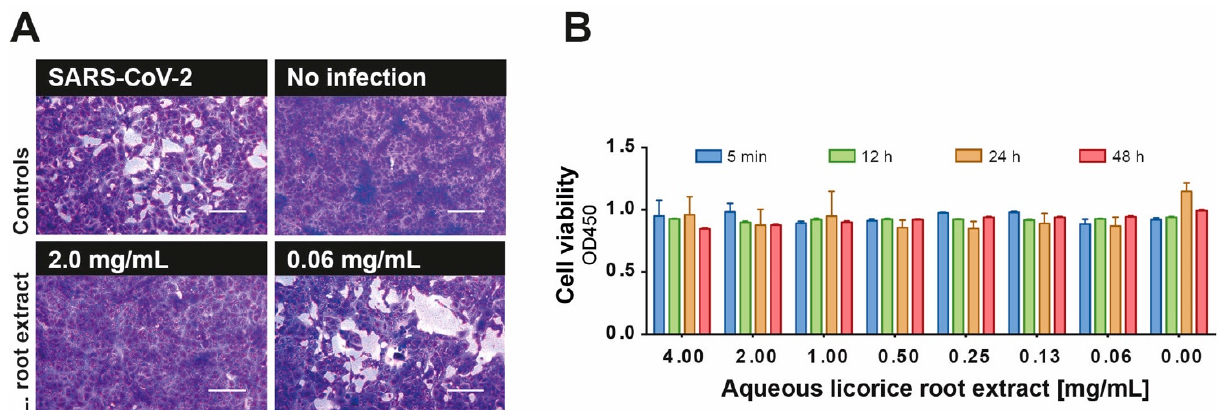
Figure 2. Potent inhibition of SARS-CoV-2 replication by the licorice root extract. ( A ) Decreasing aqueous licorice root extract concentrations (0.004–4 mg/mL) were pre-incubated with 100 TCID 50 /mL SARS-CoV-2 for 1 h at 37 °C and applied to a confluent layer of Vero E6 cells. After 48 h of incubation, cell cultures were stained with crystal violet and analyzed for plaque formation. Representative pictures of protected and infected cell cultures at the indicated concentrations are shown. Bars represent 200 μ m. ( B ) Cytotoxicity of aqueous licorice root extract towards Vero E6 cells was tested using “Orangu cell counting solution”. Different concentrations of the extract were incubated with a confluent layer of Vero E6 cells and the cell viability was evaluated at four different time points (5 min, 12 h, 24 h, 48 h). All experiments were performed in biological replicates. Error bars represent the standard error of the mean (SEM).